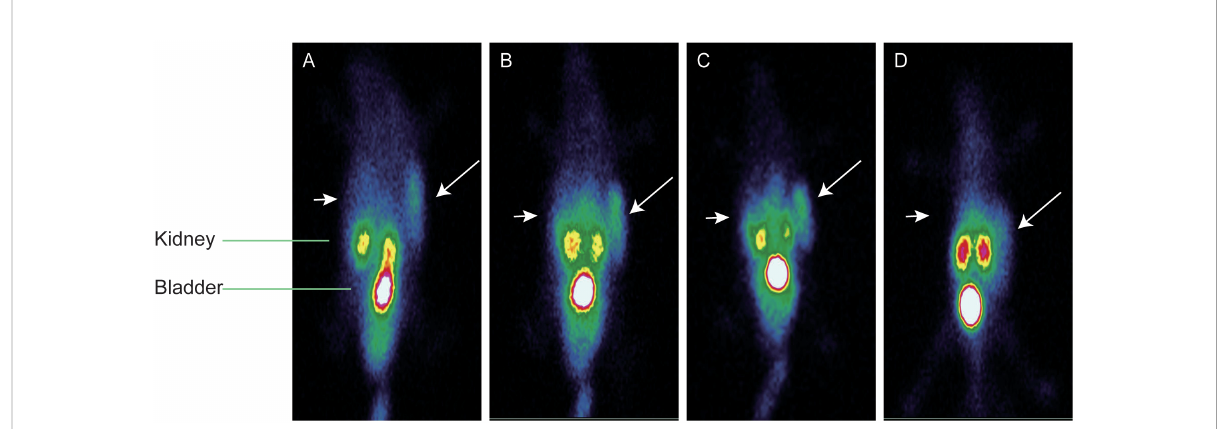
FIGURE 7 Representative single photon emission – computed tomography maximum-intensity projection images of 99m Tc-PDA in dual- fl ank MC38-B7H1/ MC38 xenograft-bearing mie; long arrows indicate MC38-B7H1 tumors, and short arrows indicate MC38 tumors. (A) Images at 30 min. (B) Images at 60 min. (C) Images at 120 min. (D) Blocking images at 60